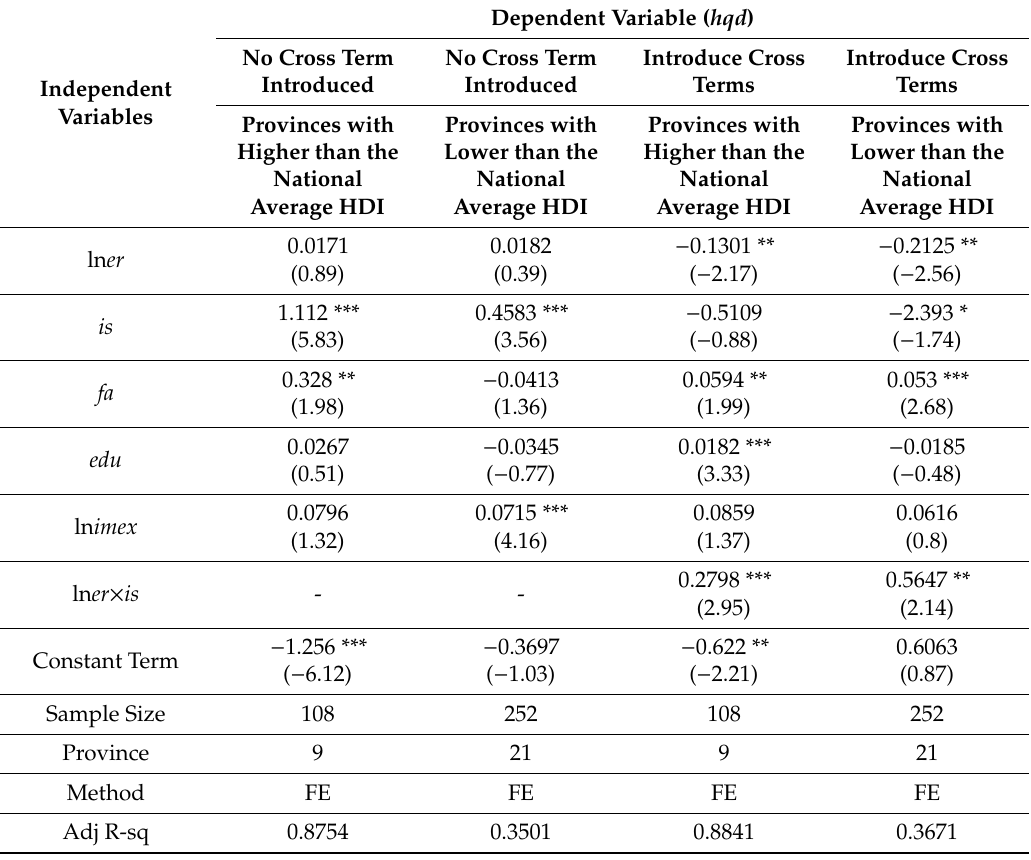
Table 4. Estimation results for the e ff ect of environmental regulations on the quality of economic development based on HDI